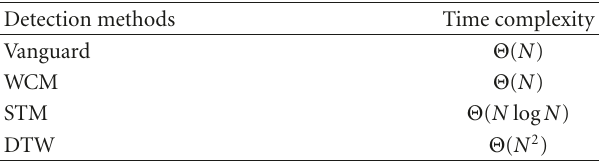
Table 2: A comparison of the detection methods’ time complexity. Detection